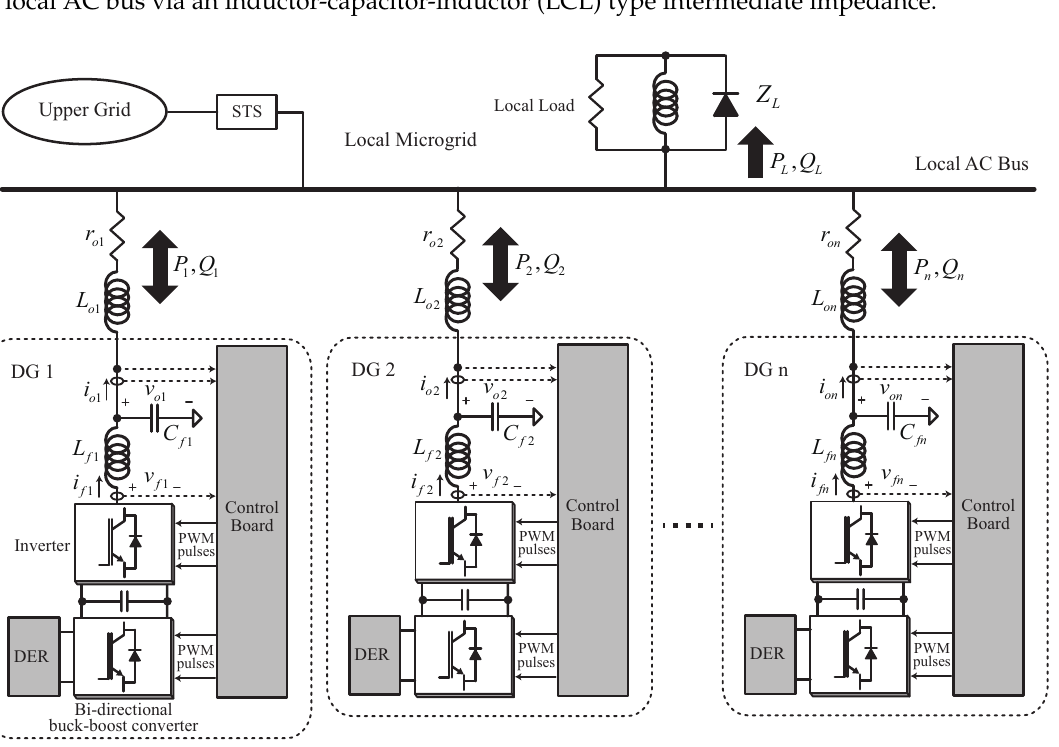
Figure 1. System configuration of inverter-based